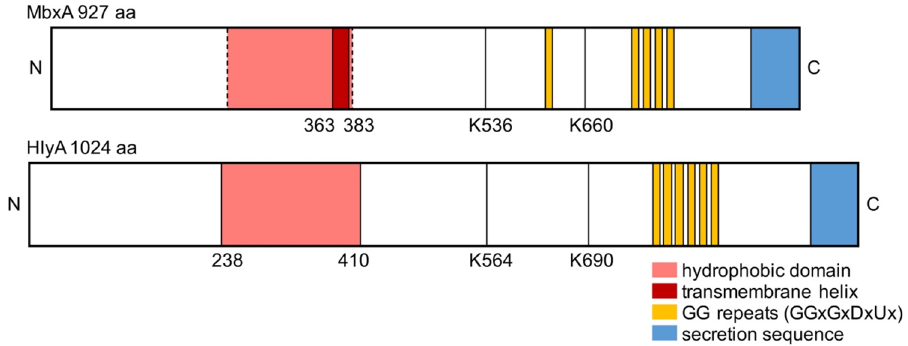
Figure 1. Schematic view of the primary structure of MbxA and HlyA. Five conserved GG repeats with the consensus sequence GGxGxDxUx are present in MbxA, while HlyA carries six conserved GG repeats